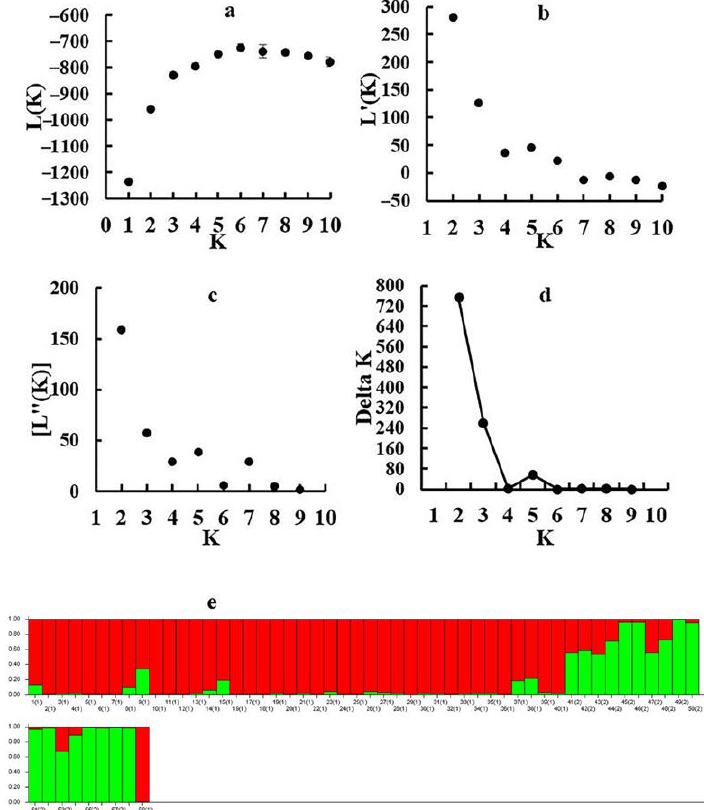
Figure 2. Results of STRUCTURE analysis for 59 populations using 14 EST-SSR markers: ( a ) Plot mean likelihood L(K) and variance per K value. ( b ) Plot of mean rate of change of the likelihood distribution L’(K) per K value. ( c ) Plot of absolute value of the second order rate of the change of the likelihood distribution |L’’(K)| per K value. ( d ) Estimation of population using Delta K value with cluster K ranging from 1 to 10. ( e ) Estimation of population structure based on STRUCTURE analysis.